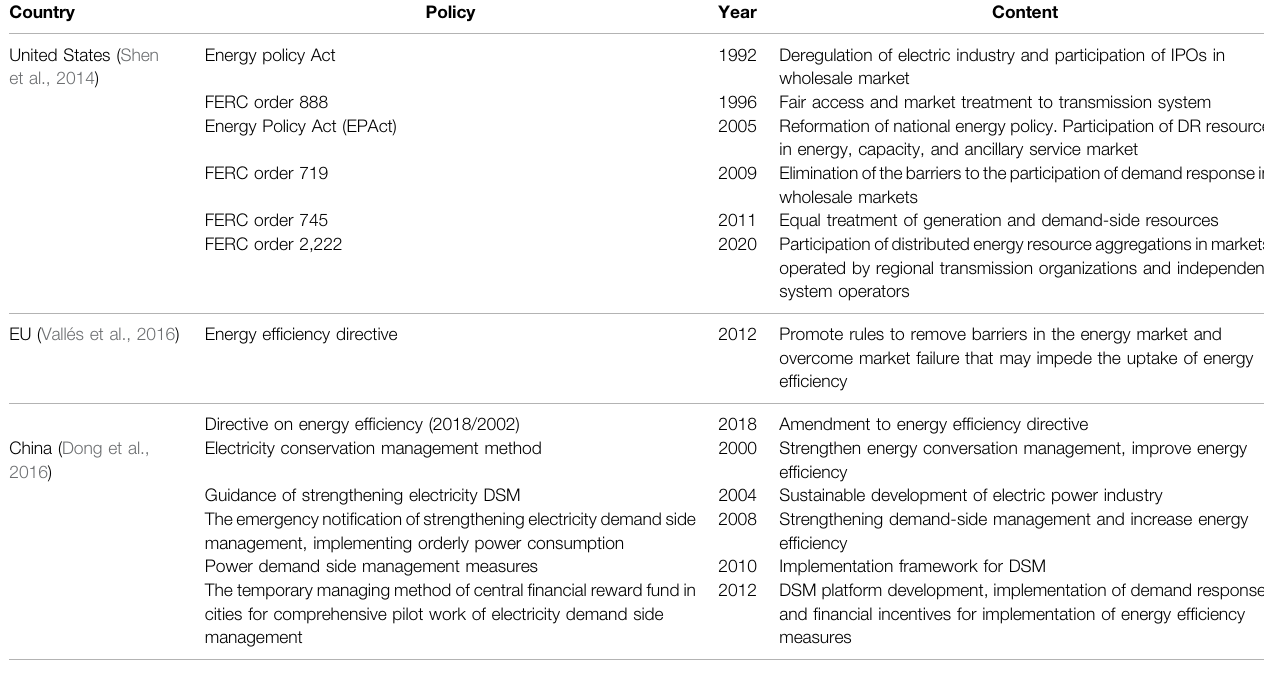
TABLE 7 | A perspective on energy policy related to DR in United States, EU, and China. Country